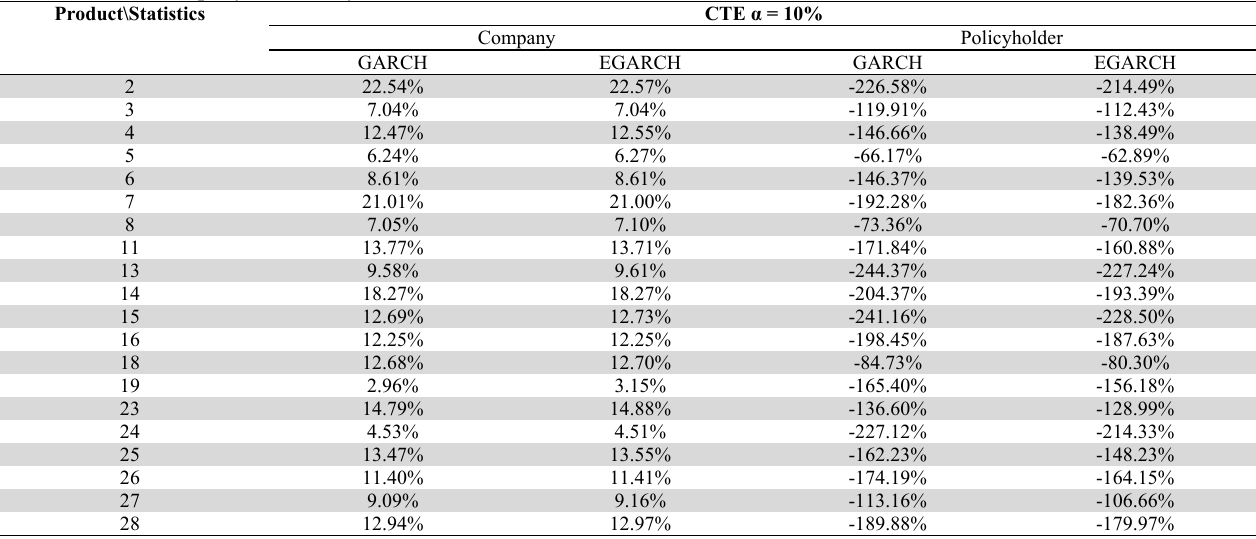
Fig. 1. The results of Mean versus policyholder Fig. 2. CTE for Company and Policyholder The bigger the distance between the top of blue bar and the bottom of the brown bar, the less fair the product is. The industry (in other words the whole products) is becoming fairer if the distance between green line (average company) and yellow line (average policyholder) is getting narrower and narrower. The average CTE for company (green line) is 11.67% and the average CTE for policyholder (yellow line) is -164.24%. CTE Result for Company and Policyholder